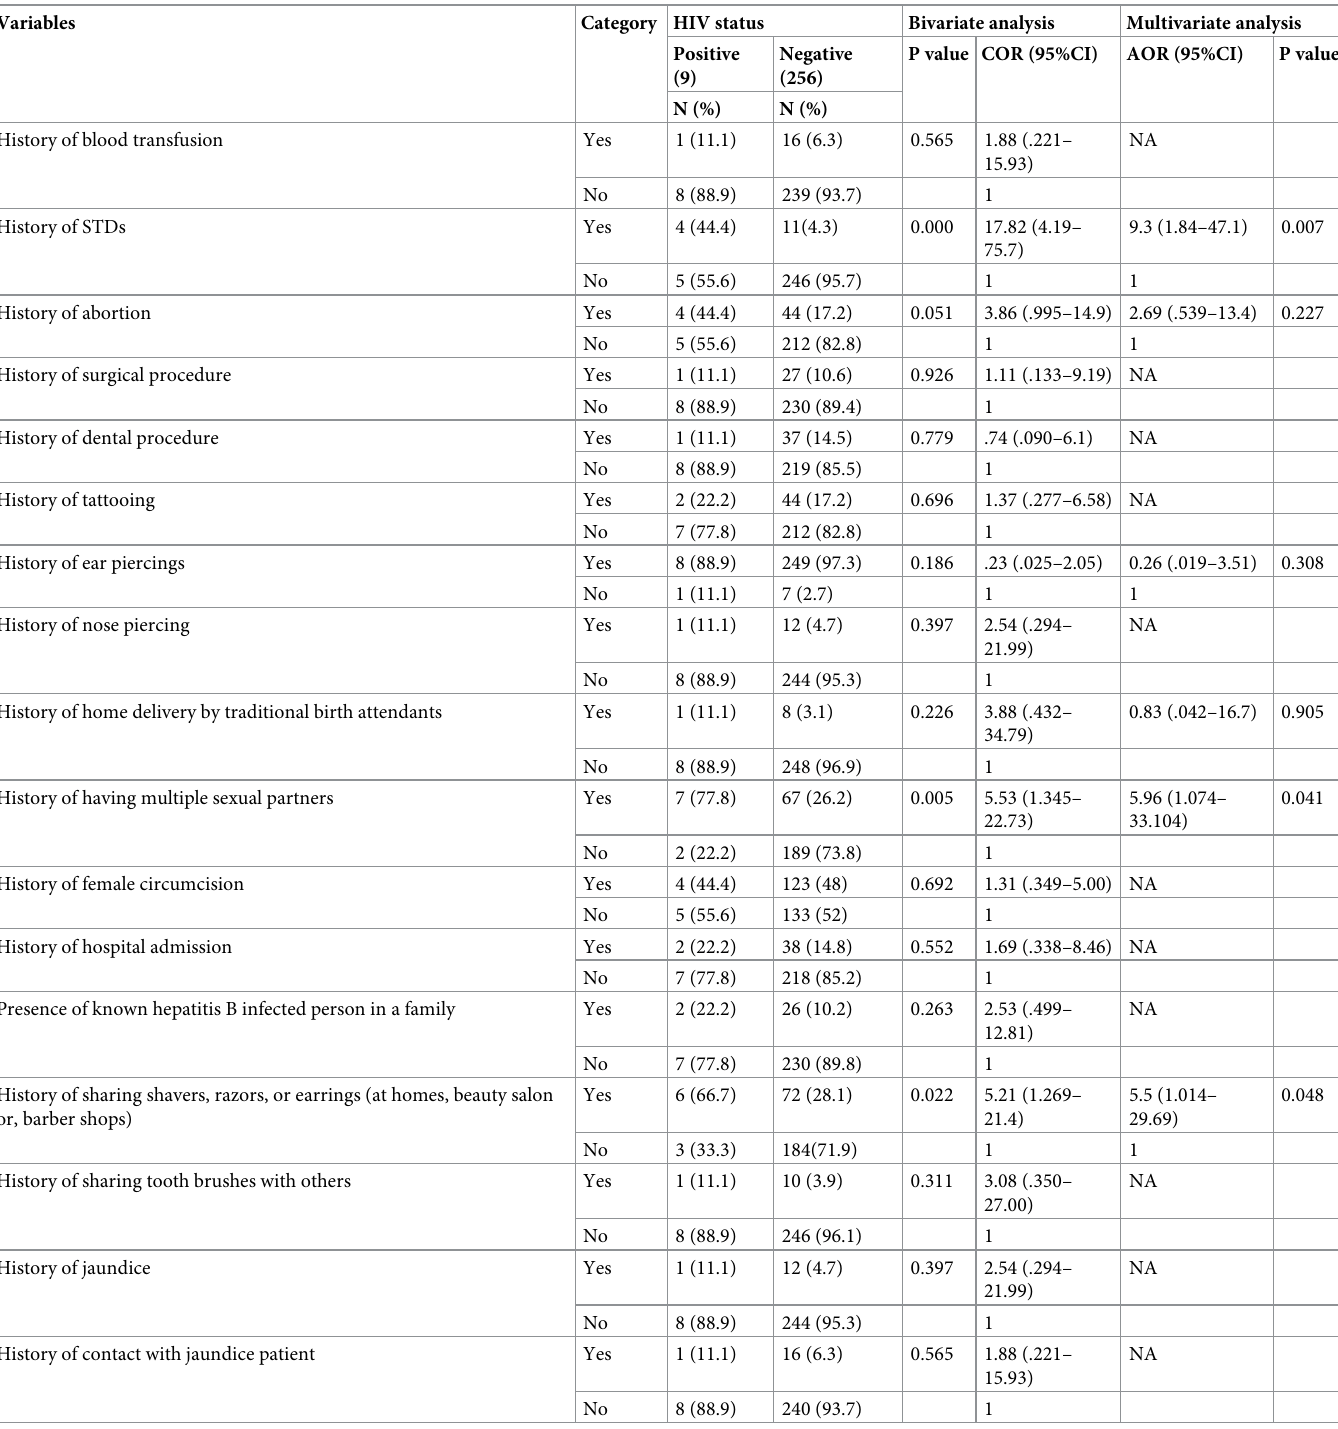
Table 3. Factors associated with HIV co-infection among HBsAg positive delivering mothers in governmental hospitals in Addis Ababa,